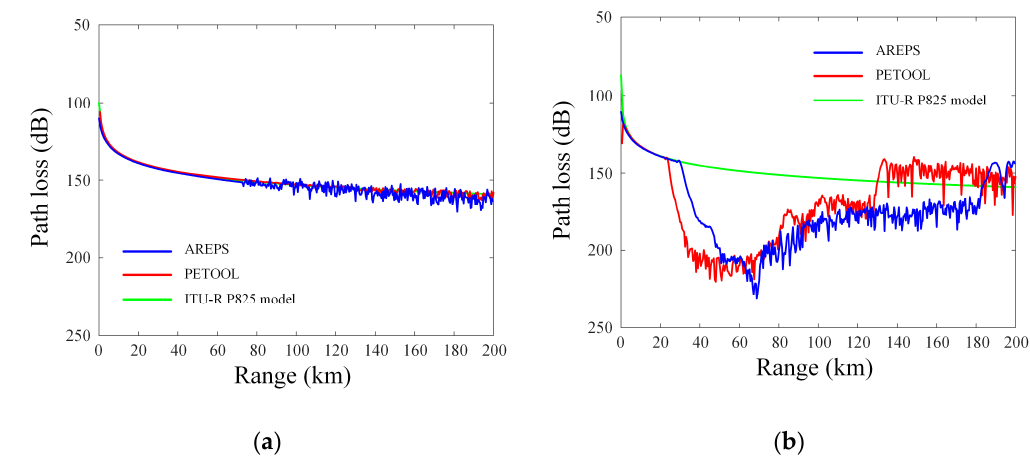
Figure 7. Path loss comparisons among the AREPS software, the PETOOL software, and the ITU-R P.528 model in terms of the atmospheric conditions: ( a ) normal atmosphere; ( b ) abnormal atmosphere.